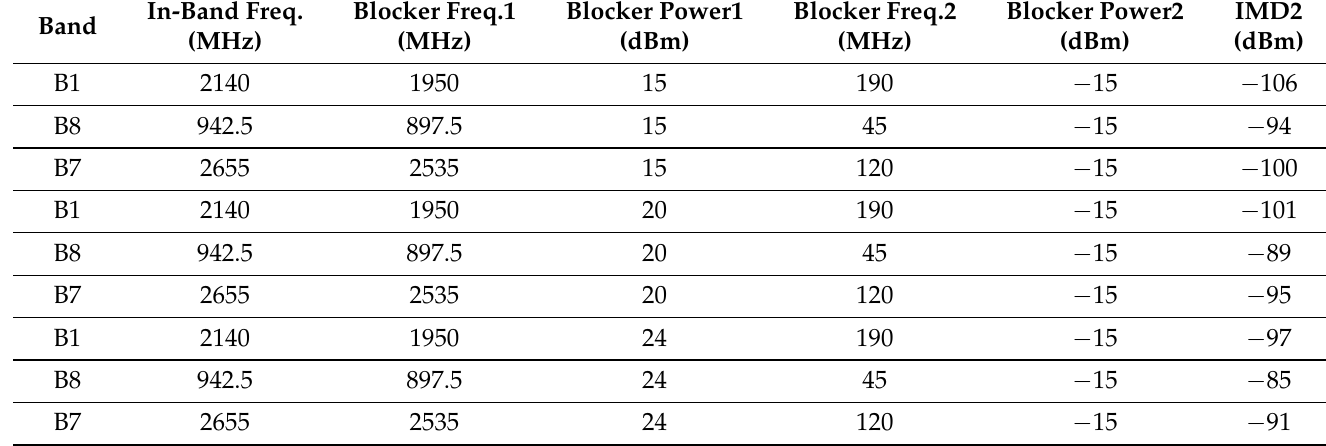
Table 1. IMD2 measurement summary.